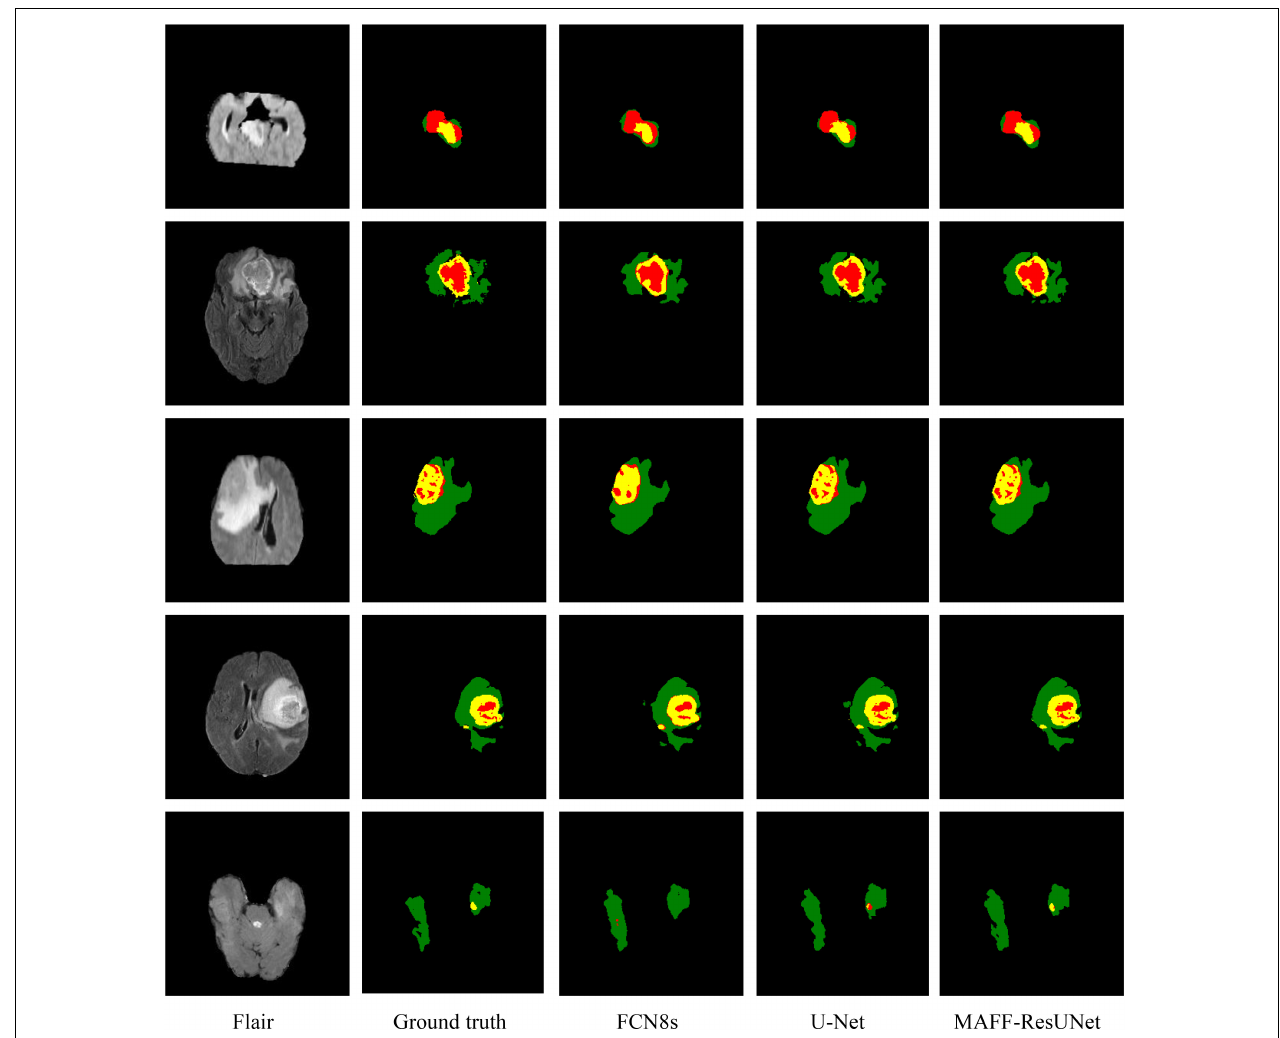
FIGURE 5 | Visualized predicted images of different models. In the ground truth image, red, green and yellow represent tumor core (TC), whole tumor (WT), and enhance tumor (ET),